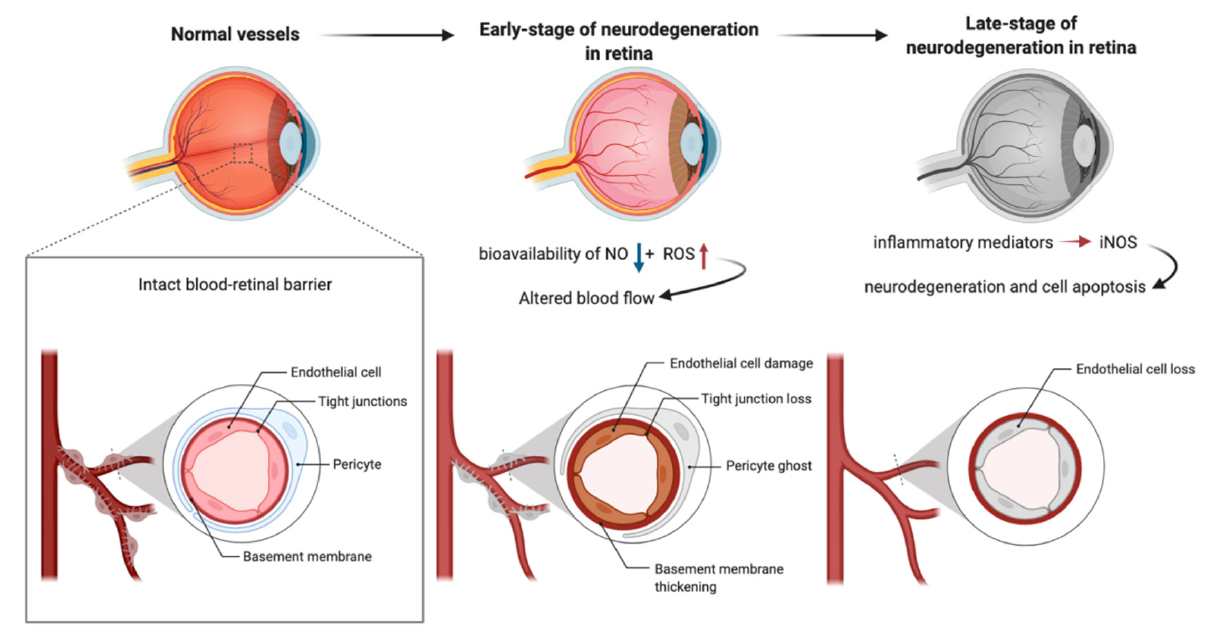
Figure 2. Endothelium and neurodegenerative diseases in retina.